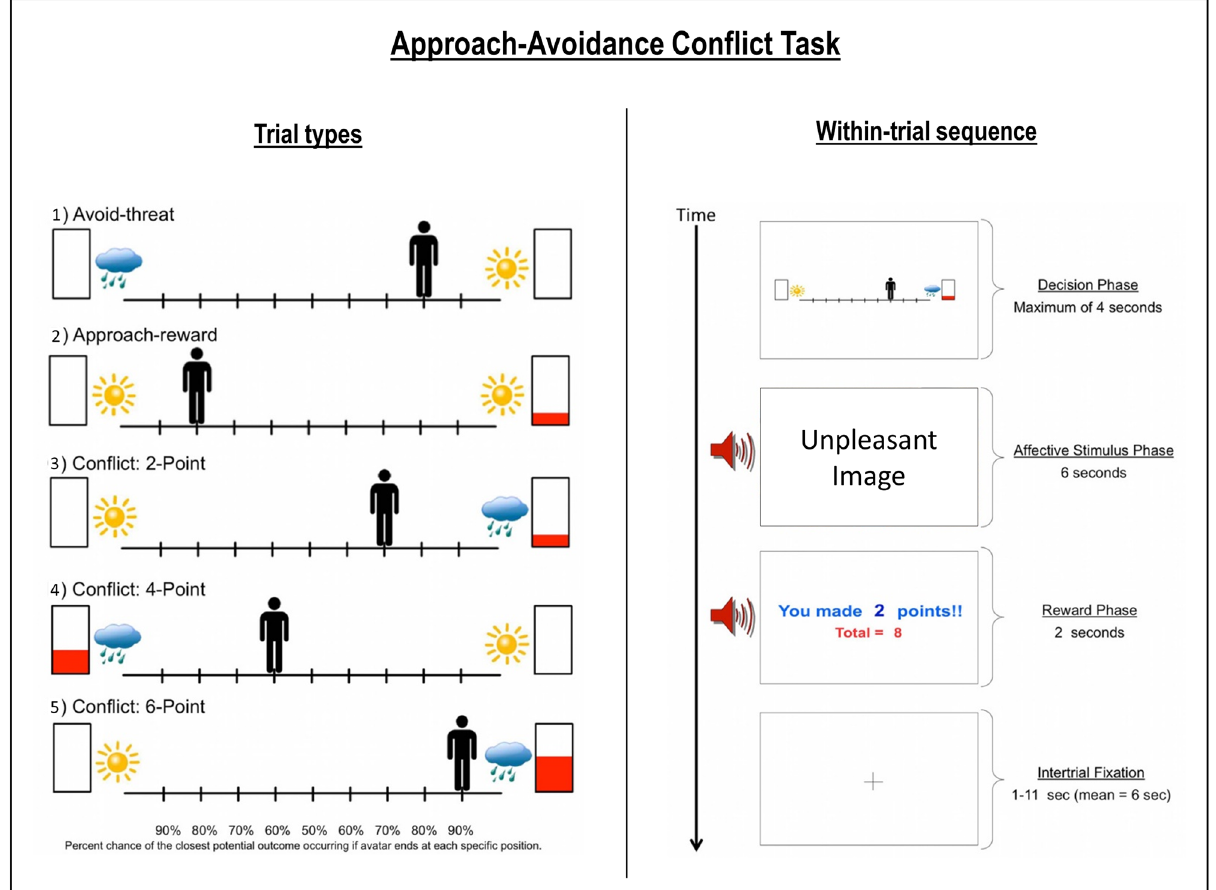
Figure 1. (Left) The five trial types. The sun indicates a positive stimulus, the cloud indicates a negative stimulus, and the higher the red bar is filled the more points may be received. (Right) Example trial in the AAC task, in which the negative stimulus and two points were presented based on the probabilities associated with the chosen runway position. This figure is modified from our previous paper 20